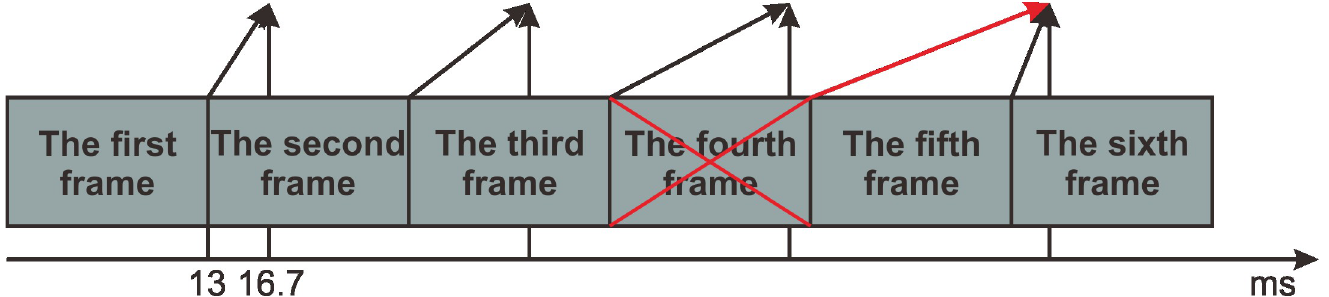
Fig 9. Frame rendering mismatched with the screen refresh rate. Suppose the screen refresh rate is 60 Hz (refresh period is approximately 16.7 ms), and the screen rendering period is set to 13 ms. Since the browser renders a page every 16.7 ms, the browser refreshes the previous picture when the page finishes rendering the next frame. Then, frame 4 becomes